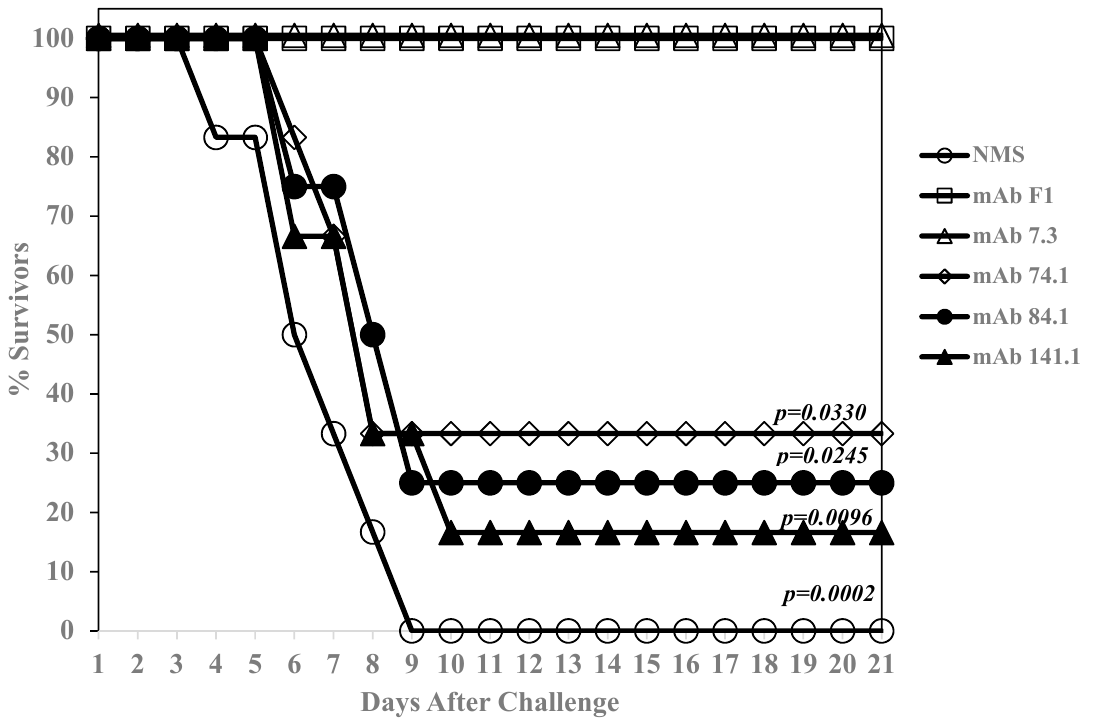
Figure 1. Passive protection conferred by purified anti-V-antigen mAbs in Swiss-Webster mice using a bubonic plague model. There were 4 or 6 mice per group with 6 groups that consisted of the anti-V mAbs (74.1, 500 µg; and 141.1, 500 µg), with 3 control groups comprising normal mouse serum (NMS), anti-V mAb 7.3 (100 µg), and anti-F1 capsule mAb (250 µg). There were only 4 mice in the group that